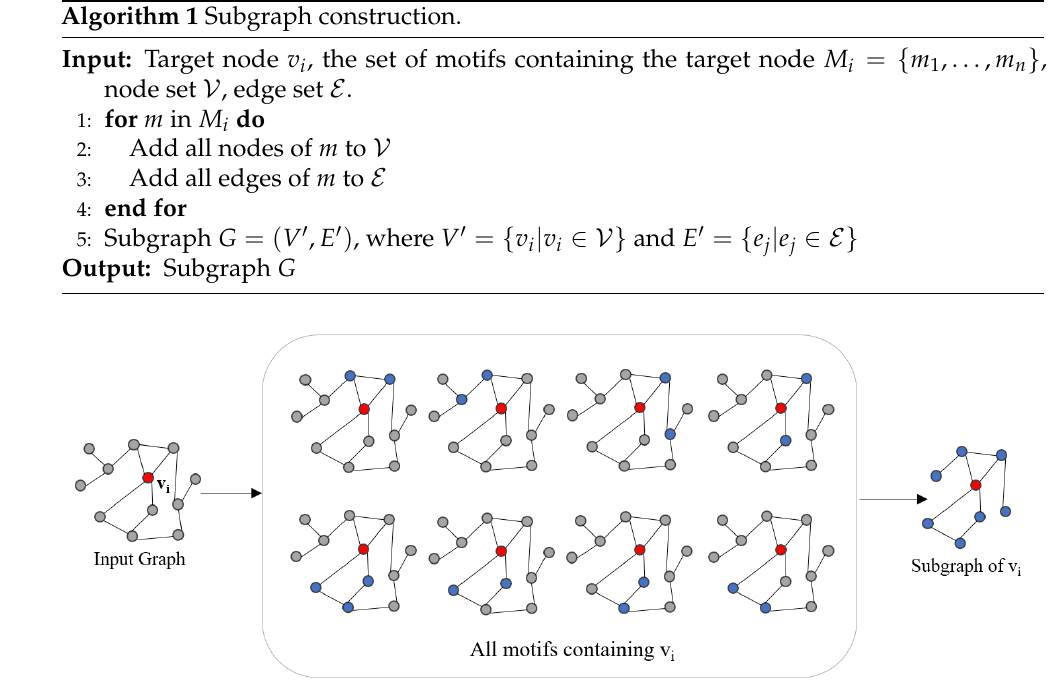
Figure 3. The process of generating subgraph for node v i on the basis of its motif information. The red node represents the target node v i and the blue nodes represent the nodes that appear in the same motif as v i . For all networks in the middle box, the blue and red nodes represent all motifs containing the target